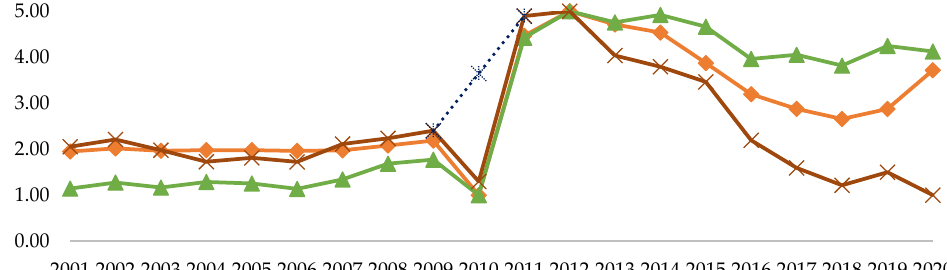
Figure 2. Evolution of normalized input variables in the interval [1, 5].